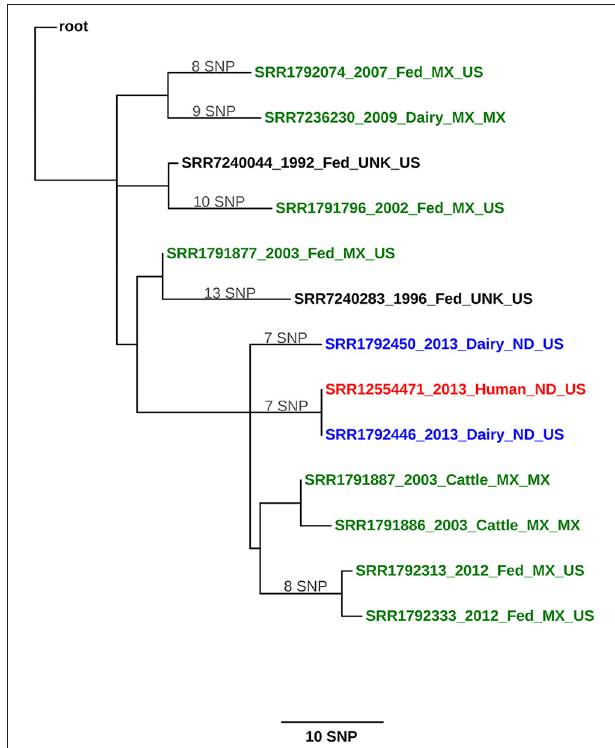
FIGURE 1 | Maximum likelihood phylogenetic tree illustrating the genetic relationship between M. bovis isolates from a cattle herd in North Dakota (United States) and a human. The color key indicates the origin of the cattle from which M. bovis was isolated: green, Mexico; blue, United States; and black, cattle whose origin could not be traced (unknown). The human isolate is shown in red. Sequences are identified using the following syntax: NCBI SRA accession number_year of isolation_ production type (dairy, fed, cattle [unknown])_geographical origin of the animal (state, country or unknown)_country of detection. The scale bar represents a branch length of 10 SNPs. The tree is rooted to the reference genome M. bovis